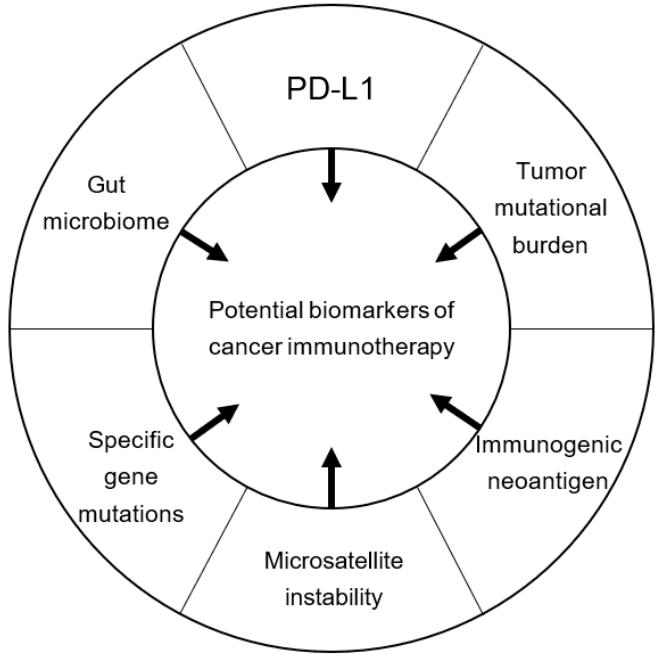
Figure 1. Potential biomarkers of cancer immunotherapy. PD-L1, programmed cell death-ligand 1.